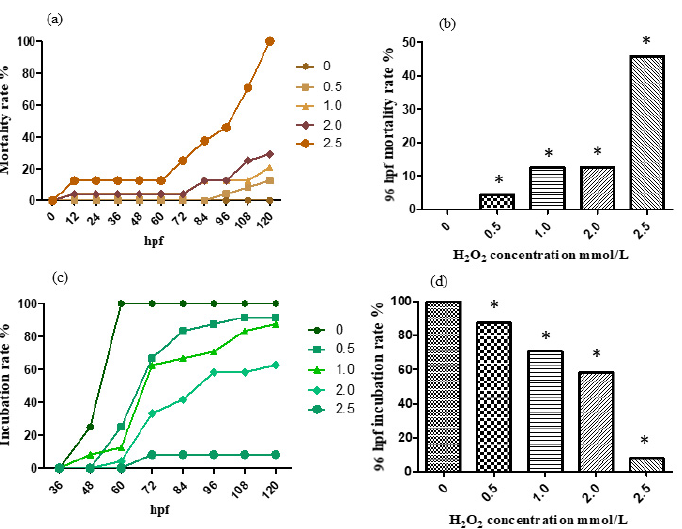
Figure 3. The mortality rate ( a , b ) and incubation rate ( c , d ) after being H 2 O 2 -treated. The results were analyzed by χ 2 test, vs. the control group (0 µ L/mL ethanol): * p < 0.05.